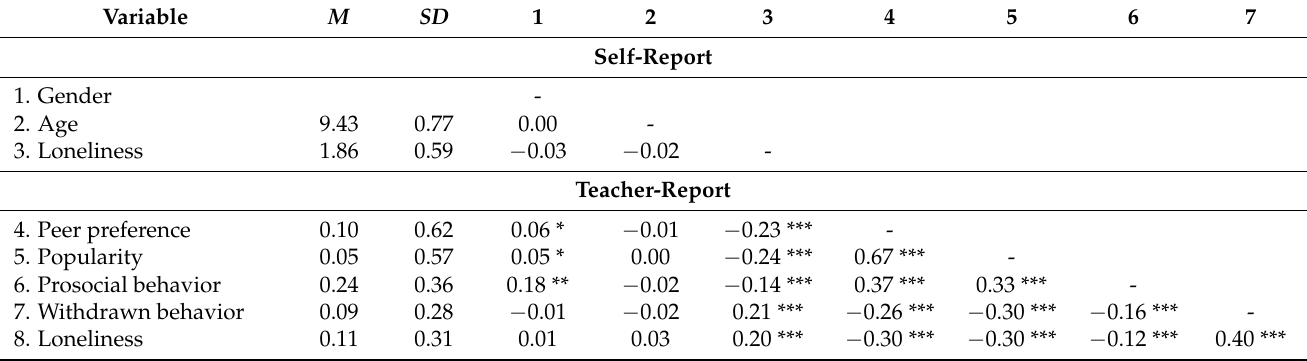
Table 1. Descriptive Statistics and Intercorrelations of Study Variables: Study 1.